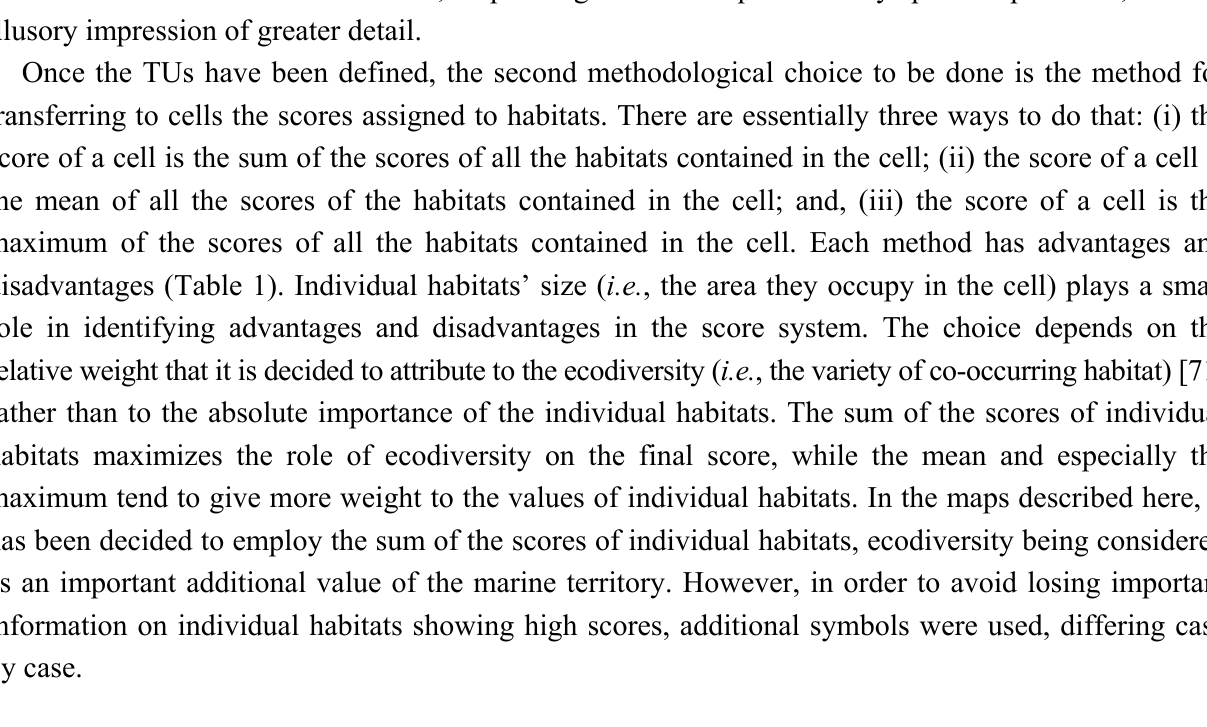
Table 1. Criteria to assign a territorial unit with a score on the basis of the scores of the habitats it contains. Advantages and disadvantages of each criterion are